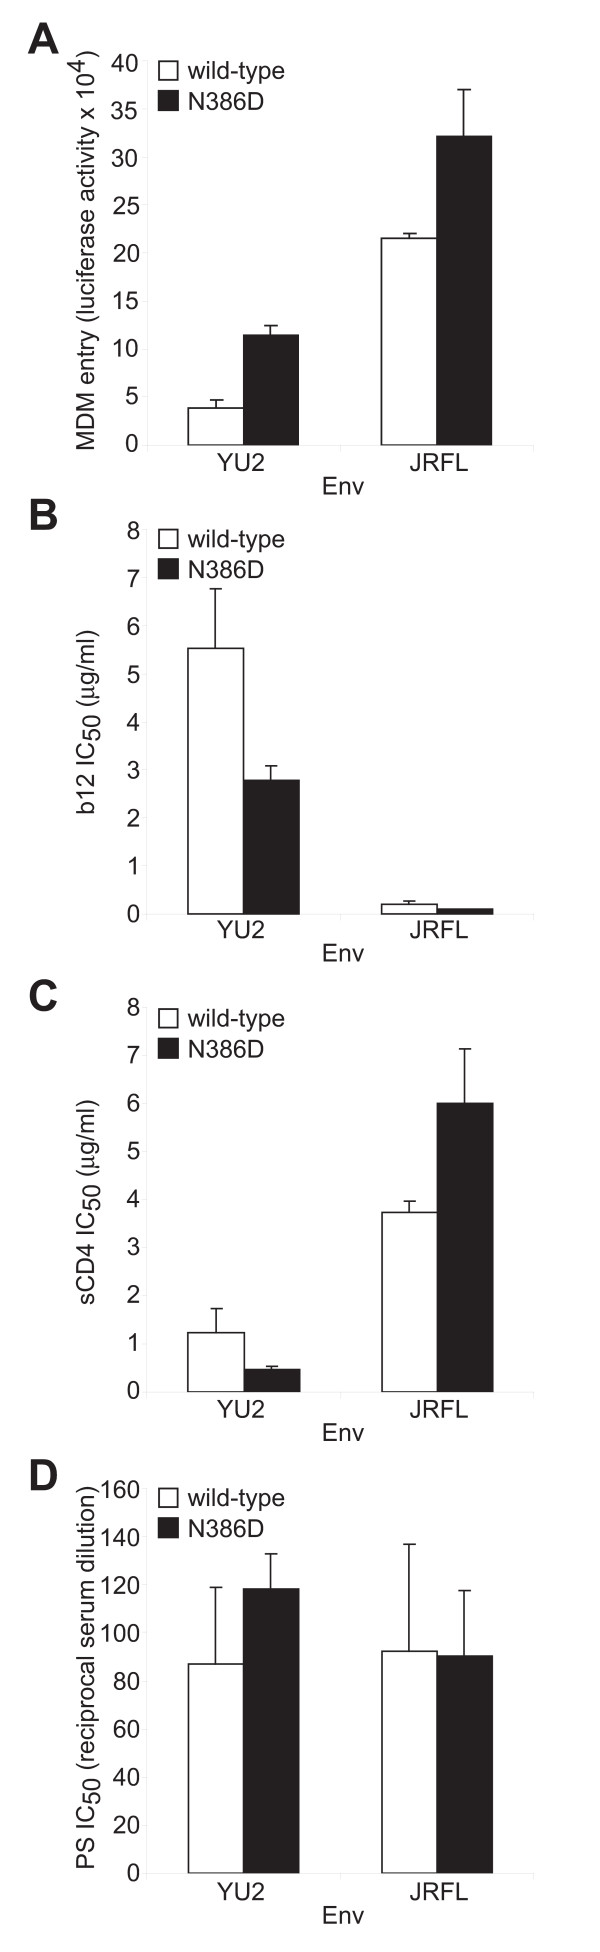
Loss of an N-linked glycan at position 386 in primary HIV Envs enhances macrophage tropism and neutralization sensitivity to mAb b12. (A) MDM were infected with luciferase-expressing reporter viruses expressing wild-type or N386D mutant Envs. Cells were lysed 6 days post-infection and analyzed for luciferase activity. (B, C, D) Luciferase-expressing reporter viruses expressing wild-type or N386D mutant Envs were incubated with a range of concentrations of human mAb b12 (B), sCD4 (C), or a HIV-1 neutralizing patient serum (PS; D) 1 h prior to infection of Cf2 cells transiently expressing CD4 and CCR5. Cells were harvested 48 h post infection and assayed for luciferase activity. Data are expressed as the concentrations at which luciferase expression was reduced by 50% compared to infection in the absence of mAb (IC50). Error bars represent standard deviations.